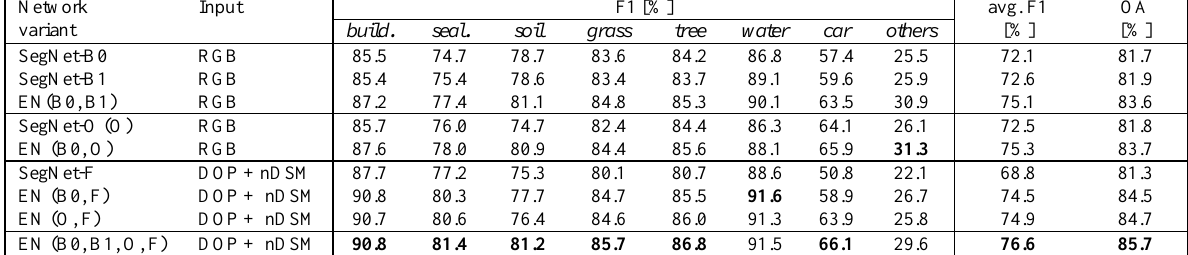
Table 1 . Results of land cover classification. Network variant: cf. section 5.1.1. F1: F1 score, OA: Overall Accuracy, both evaluated on the basis of pixels. Best scores are printed in bold font.